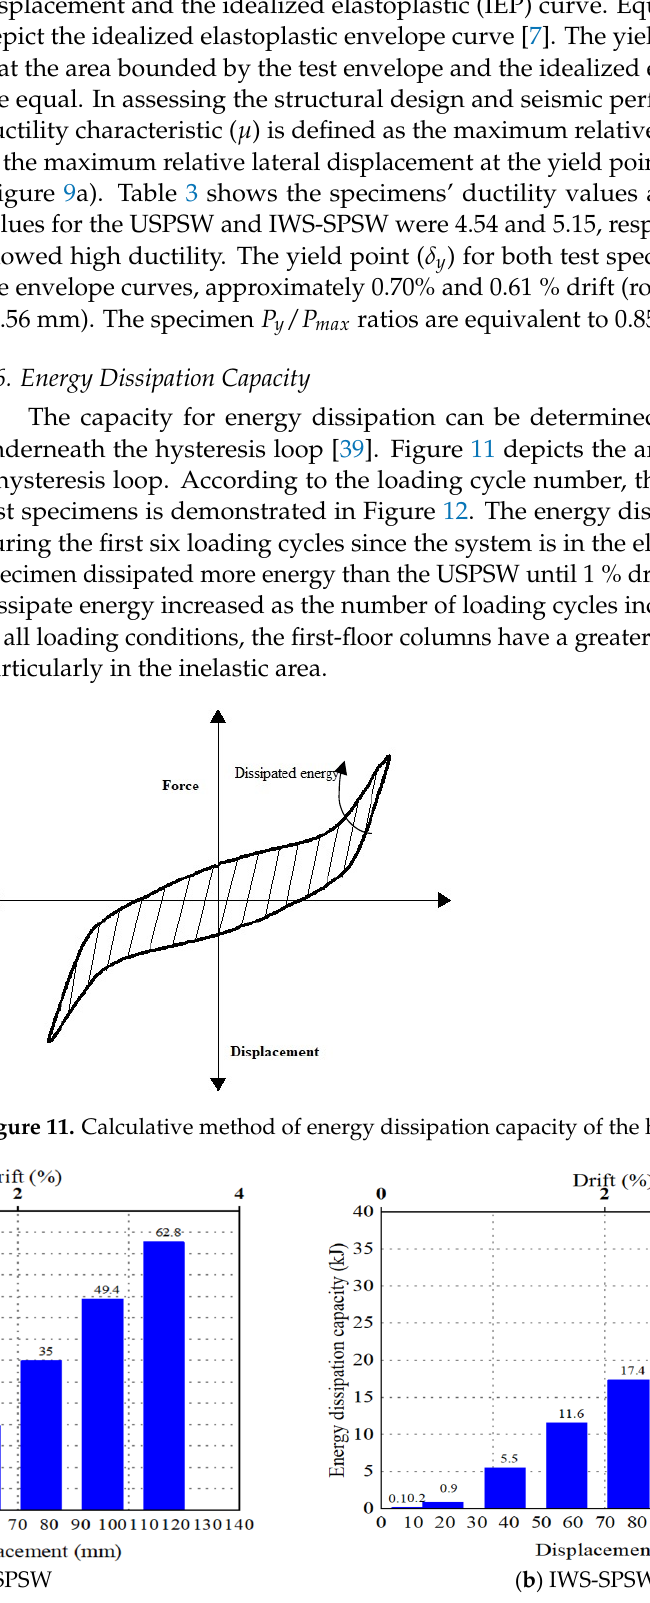
Figure 12 . Energy dissipation capacity in the specimens .